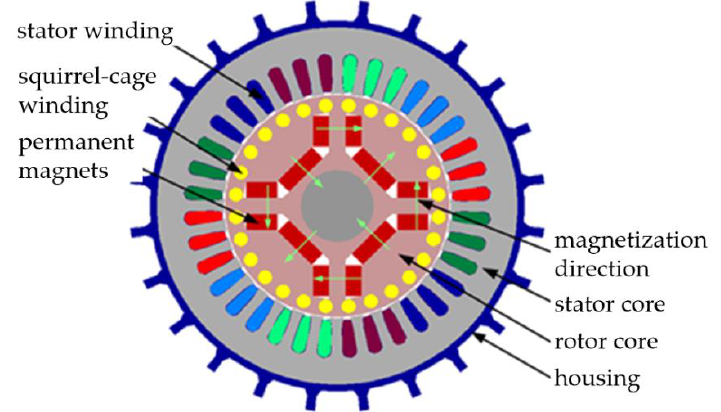
Figure 3. The structure of line start permanent magnet synchronous motor (LSPMSM).